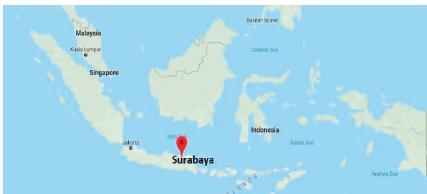
Figure 1: Map of Indonesia and spatial location of Surabaya